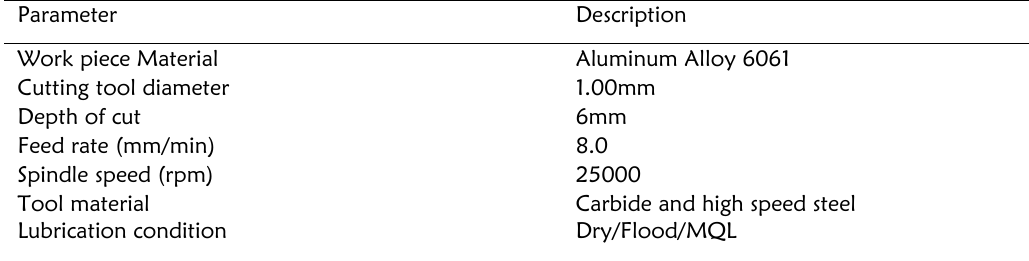
Table 1: Experimental Parameters